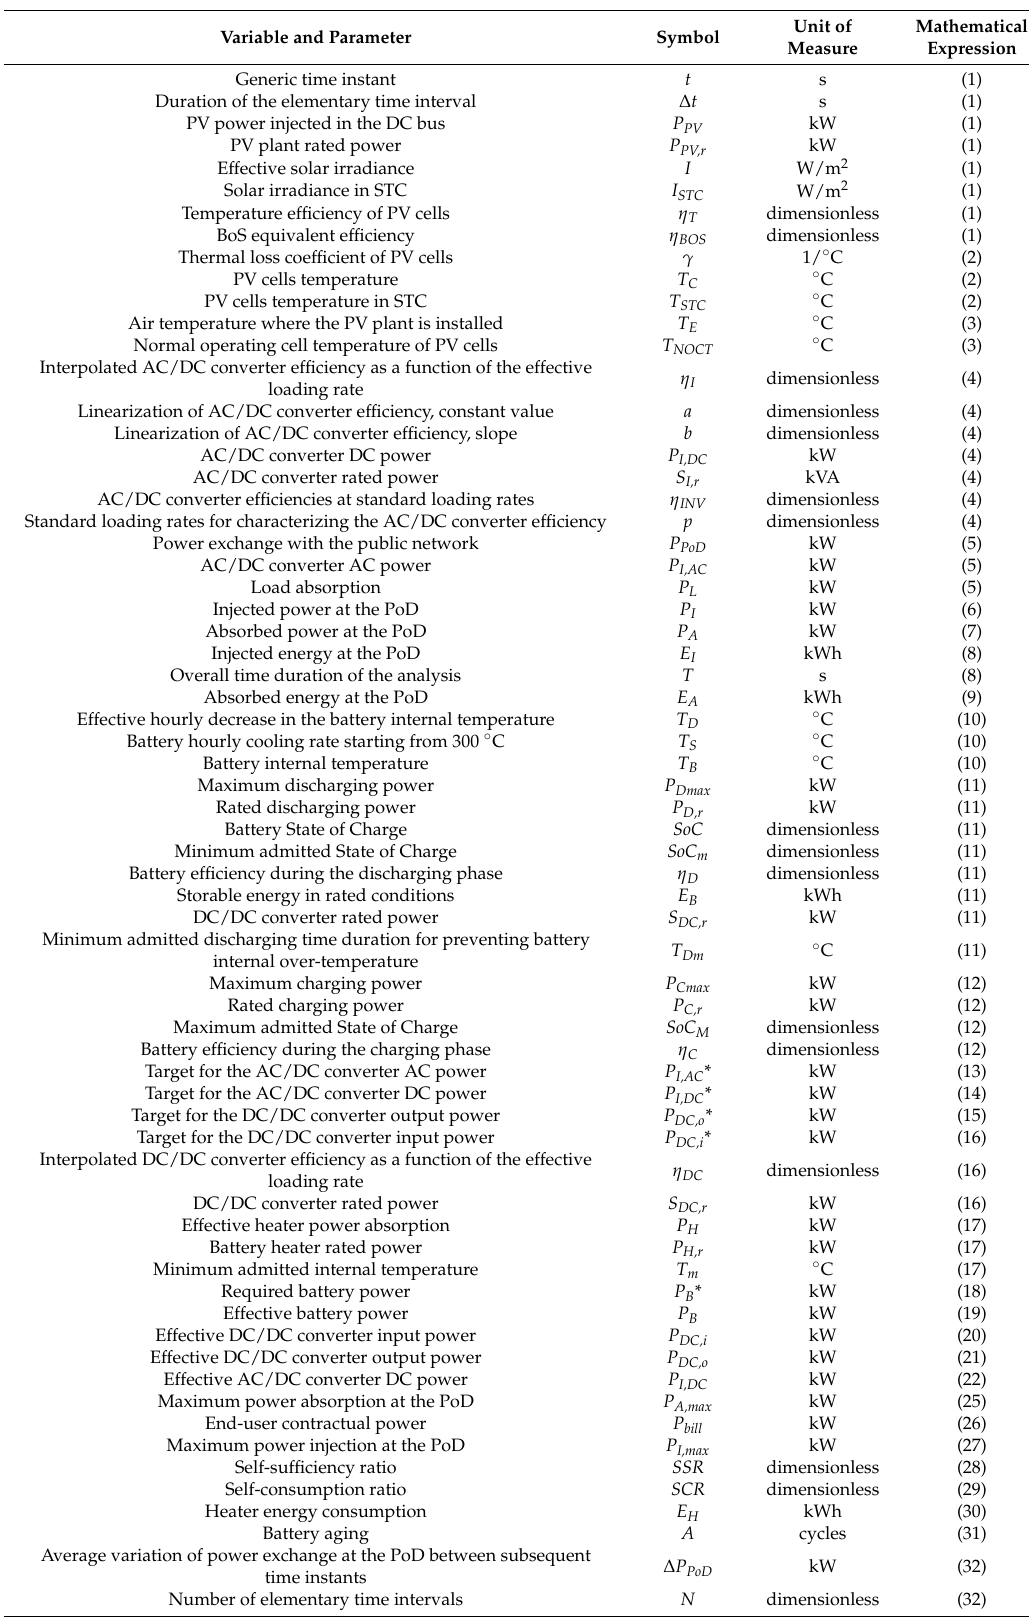
Table 2. List of variables and parameters, with indications of the mathematical expressions in which they first